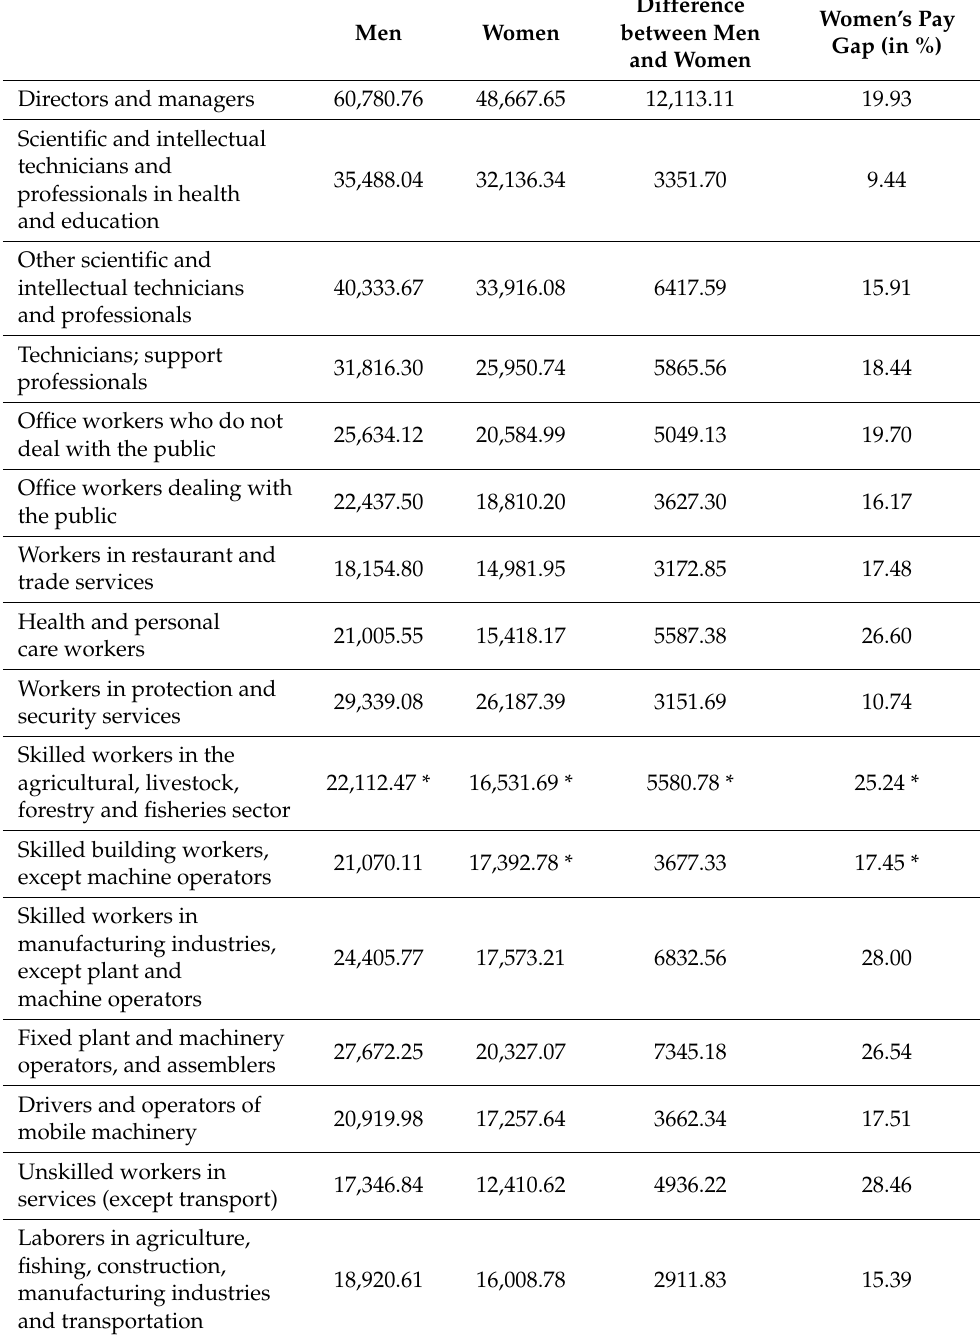
Table 10. Annual average earnings per worker by sex and activity sector in 2019 (in